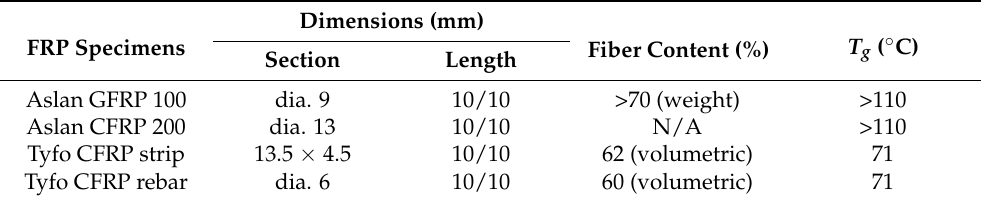
Table 4. Properties of NSM FRP specimens used for the thermal expansion